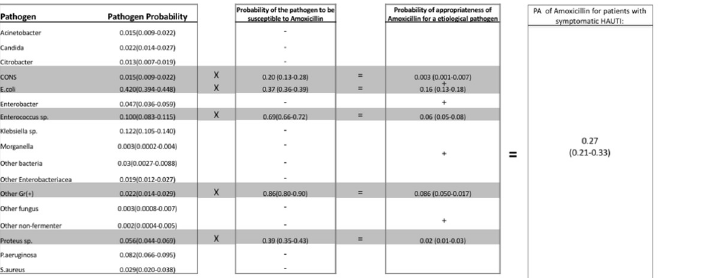
Fig 3. A practical example of calculating the WISCA for Amoxicillin in patients with symptomatic HAUTIs. Values are given as means and 95% uncertainty range. Amoxicillin can act against wild type E . coli , Proteus spp, Enterococcus spp, Coagulase (-) Staphylococcus (CONS) and other gram(+) isolates. The probability that each of these isolates cause a symptomatic HAUTI within the GPIU data is; 0.42, 0.056, 0.1, 0.015 and 0.022 respectively. The probability that each of these etiological pathogens are susceptible to Amoxicillin is; 0.37 (0.36–0.39), 0.39 (0.35–0.43), 0.69 (0.66–0.72), 0.20 (0.13–0.28) and 0.86 (0.80–0.90) respectively. The probability that Amoxicillin can cover each respective pathogen is; 0.16 (0.42 � 0.37), 0.02 (0.057 � 0.39), 0.06 (0.1 � 0.69), 0.003 (0.015 � 0.20) and 0.086 (0.022 � 0.86). By adding these probabilities up, the WISCA of Amoxicillin in HAUTIs is calculated to be